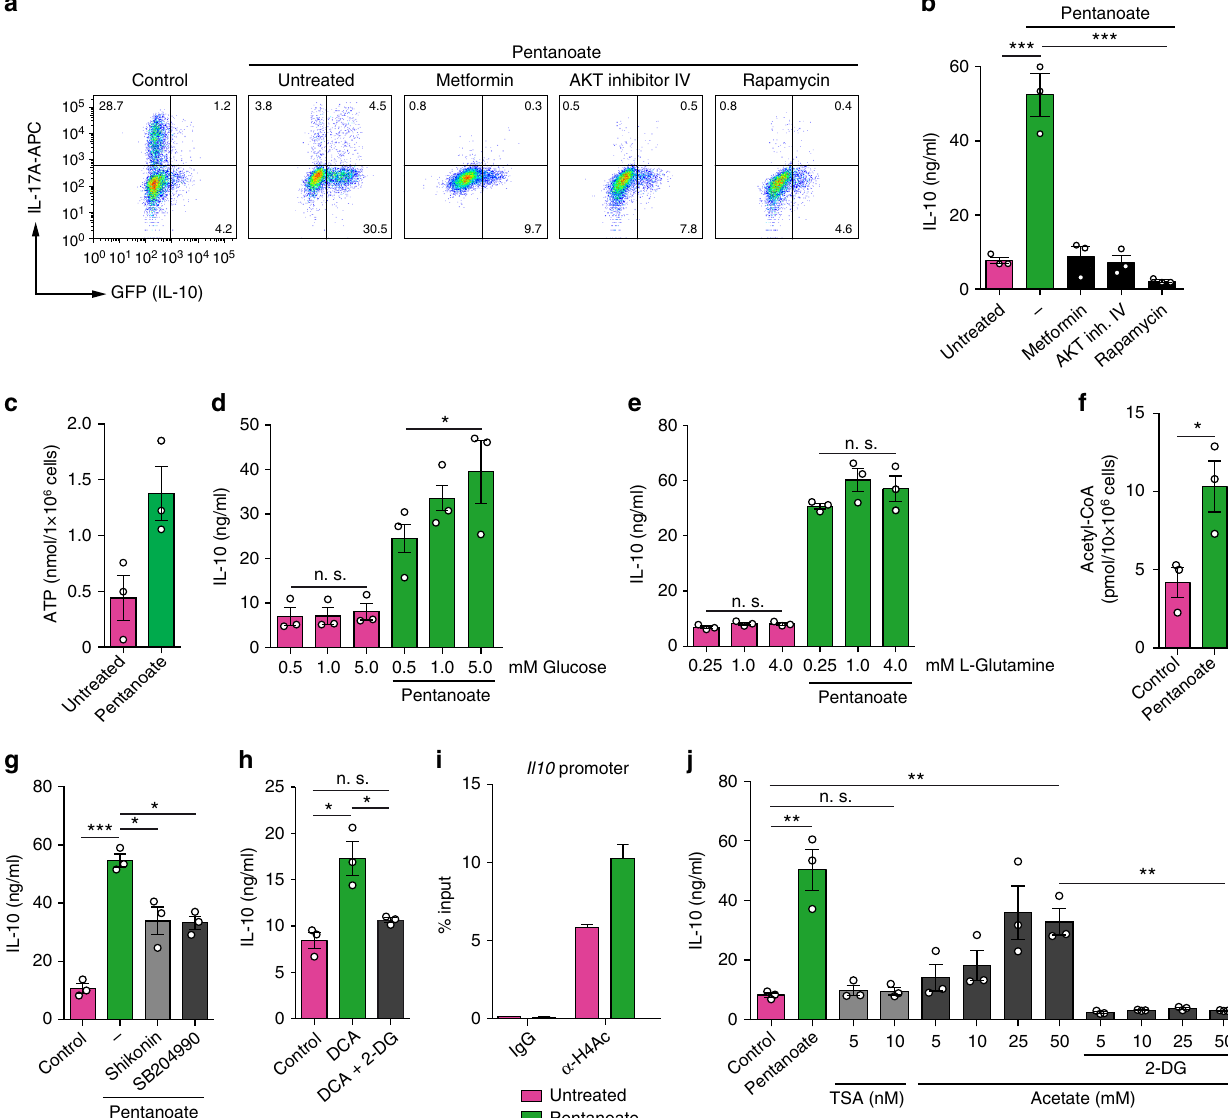
Fig. 3 Pentanoate-mediated glucose oxidation is linked to induction of IL-10 expression. a , b Th17 cells puri fi ed and generated from the spleens and LNs of FIR x tiger mice were treated with AMPK activator (metformin) or AKT (AKT inhibitor IV) and mTOR (rapamycin) inhibitors in the presence of pentanoate. The frequency of IL-10 + and IL-17A + cells within Th17 lymphocytes was analyzed by fl ow cytometry ( a ). The secretion of IL-10 was determined by ELISA ( b ). Three experiments were performed. c ATP production by Th17 cells in the absence or presence of pentanoate (2.5 mM). Three experiments were performed. d , e Th17 cells were treated with 2.5 mM pentanoate in the presence of increasing concentrations of glucose ( d ) or L-Glutamine ( e ). Three experiments were performed. f Cellular acetyl-CoA concentrations in pentanoate-treated Th17 cells were measured using fl uorometric acetyl-CoA assay kit. g IL-10 secretion by pentanoate-treated Th17 cells in the presence of PKM2 (shikonin) or ACLY (SB204990) inhibitors was measured by ELISA ( n = 3). h Th17 cells were treated with DCA in the presence or absence of 2-DG for 3 days. IL-10 secretion was determined by ELISA ( n = 3). i ChIP analysis of acetylated H4 at the Il10 promoter in pentanoate-treated Th17 cells. Three similar experiments were performed. j IL-10 secretion by Th17 cells cultured for 3 days upon TSA or acetate treatment. Pentanoate-treated Th17 cells served as a positive control for ELISA measurement. Acetate-treated cells were additionally treated with 2-DG (1 mM). Error bars indicate SEM. n.s. = not signi fi cant, * P < 0.05, ** P < 0.01, *** P < 0.001 (Student's t